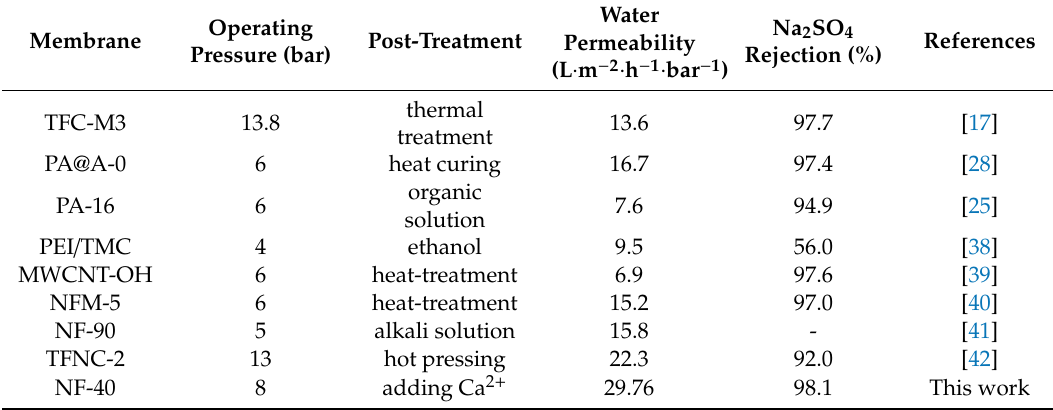
The performance comparison of NF-40 with other NF membranes with various post-treatment